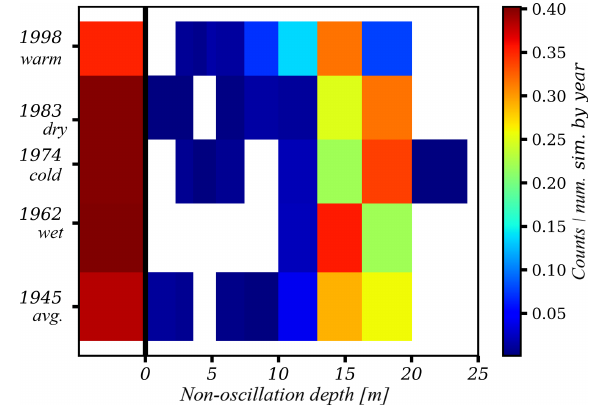
Figure 9. The 2-D histogram of climate condition (years) and h T - non-oscillation depth. Counts are normalized by the number of sim- ulations per year. The thick black line separates the frequency of reaching and not reaching the h T -non-oscillation conditions; bins to the left of this line are for simulations that never reached the h T - non-oscillation condition.